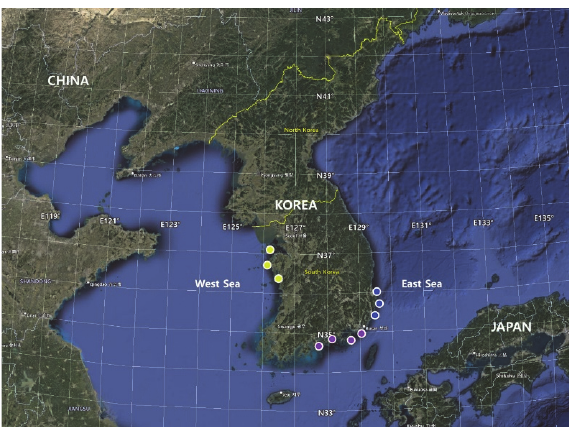
Figure 2. Locations of N. phocaenoides samples. E, East Sea (blue circle); S, South Sea (purple circle); W, West Sea (yellow circle).